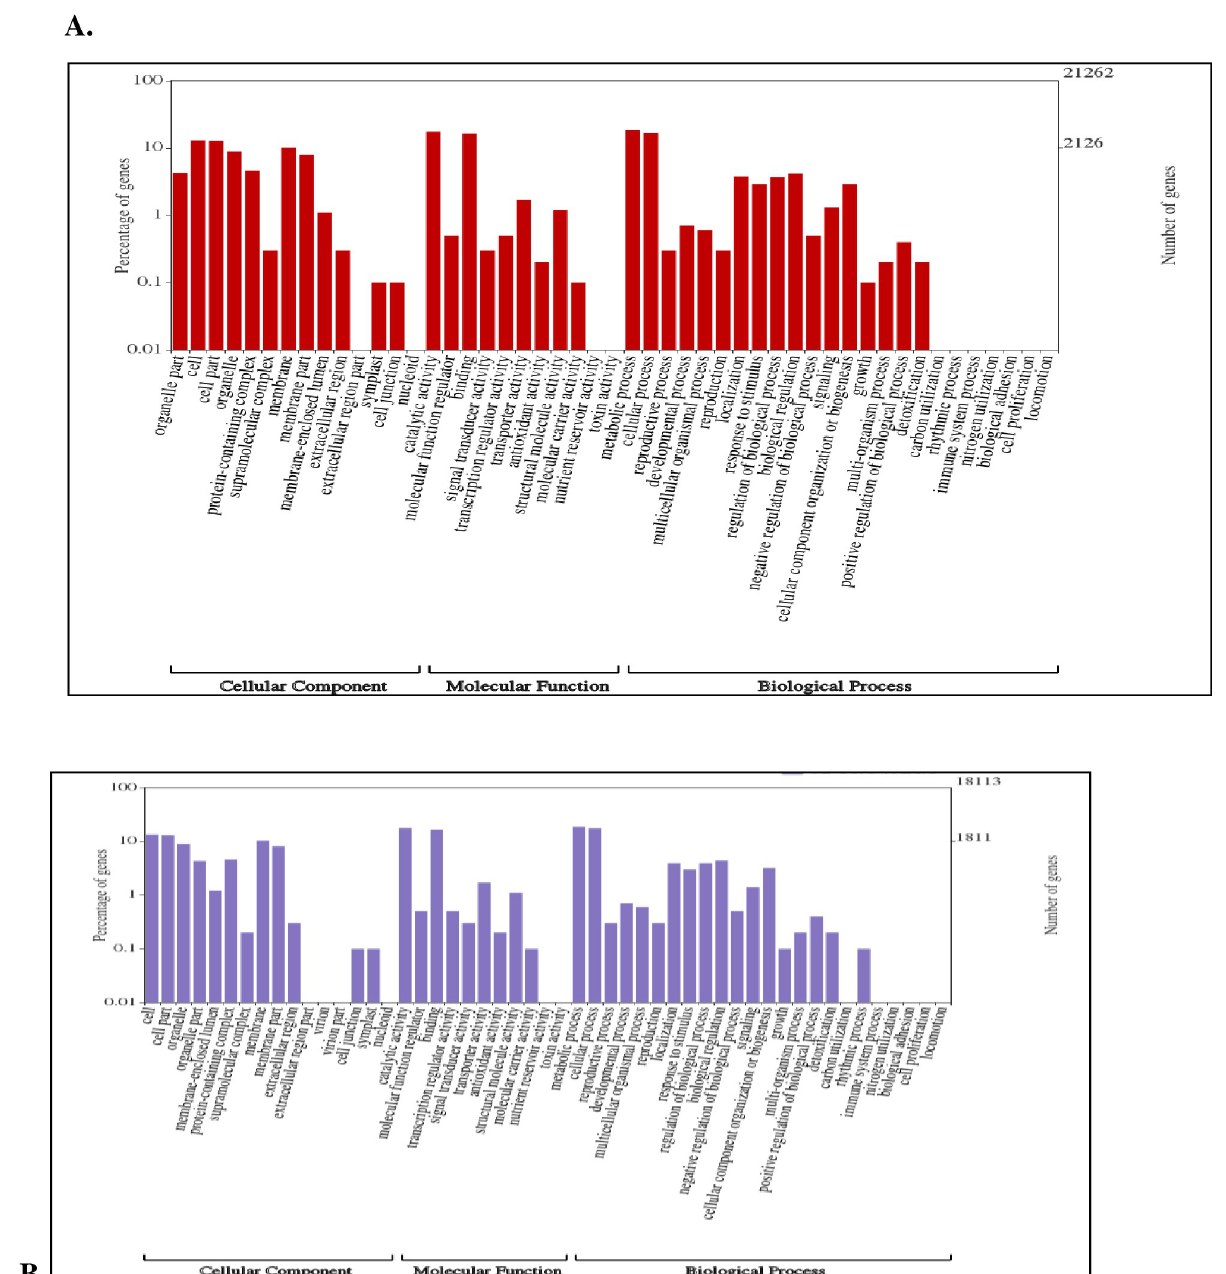
Fig 5. Heat map depicting the top 50 differentially expressed genes (significant); base mean Sa SHc represents the normalized expression values for Sa SHc sample and base mean and Sa SLc represents the normalized expression values for DGE combination. TFIIE subunit β (K03137, 0.27) (14) transcription initiation factor TFIID subunit- 9B (K03133, 0.18) (S5 Table). Nine genes were expressed downregulated with FC range from -578 to -0.63. It included (1) DNA excision repair protein ERCC-3 , 2 copy (K10844, -0.75), (2) transcription initiation factor TFIID subunit1 (K03125, -0.57), (3) transcription initiation factor TFIID sub- unit4, two copy (K03129, -0.17), (4) transcription initiation factor TFIID subunit12 (K03126,